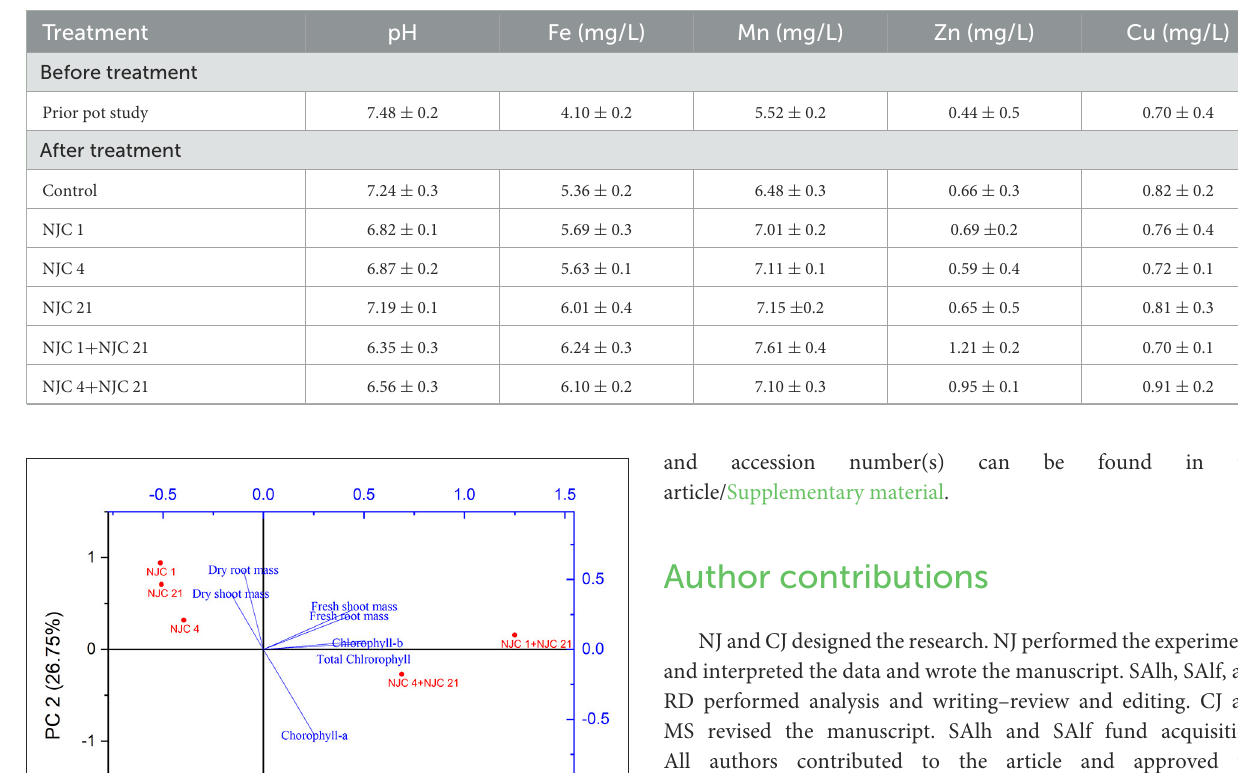
TABLE 5 Soil profiling prior and later the pot experiment from each treatment.